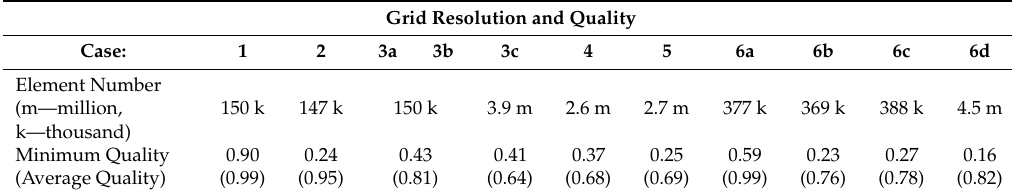
Table A2. Grid resolution and quality.